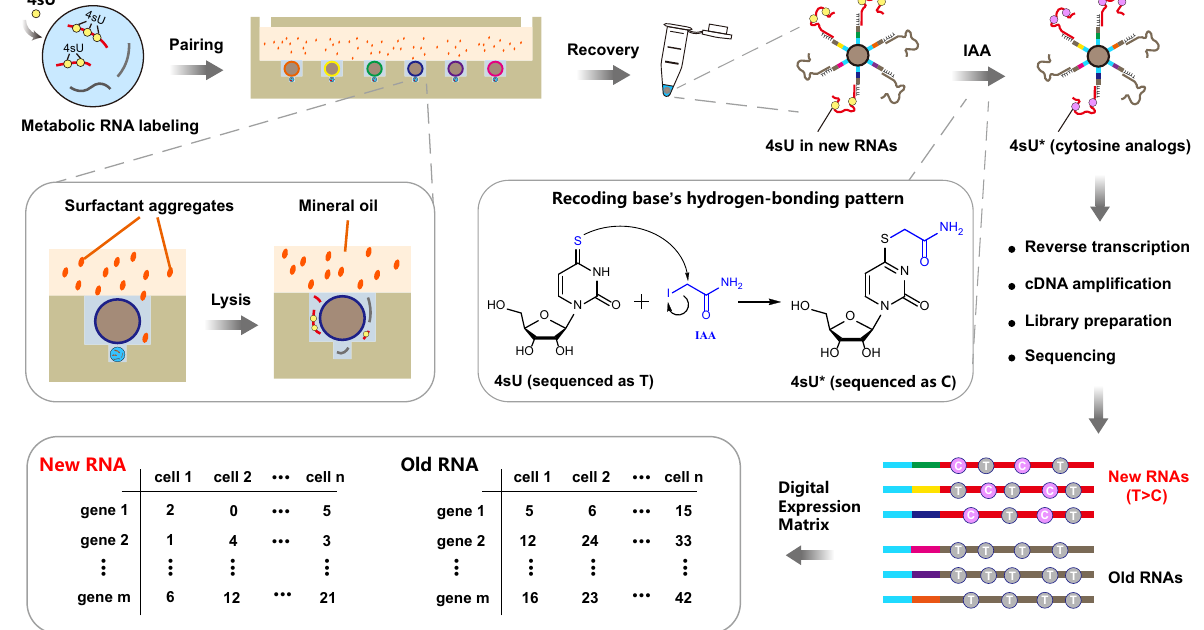
Fig. 1 | Overview and work fl ow of Well-TEMP-seq. Cells are fi rst incubated with 4sU to label newly transcribed RNAsand are thenloaded into Well-paired-seq chip forsinglecell/beadpairing.Aftercelllysisbysurfactantaggregates(sakosyl),RNAs are captured by DNA-barcoded beads and subjected to IAA (iodoacetamide) treatment to transform 4sU to a cytosine analog (4sU*), which induces T-to-C